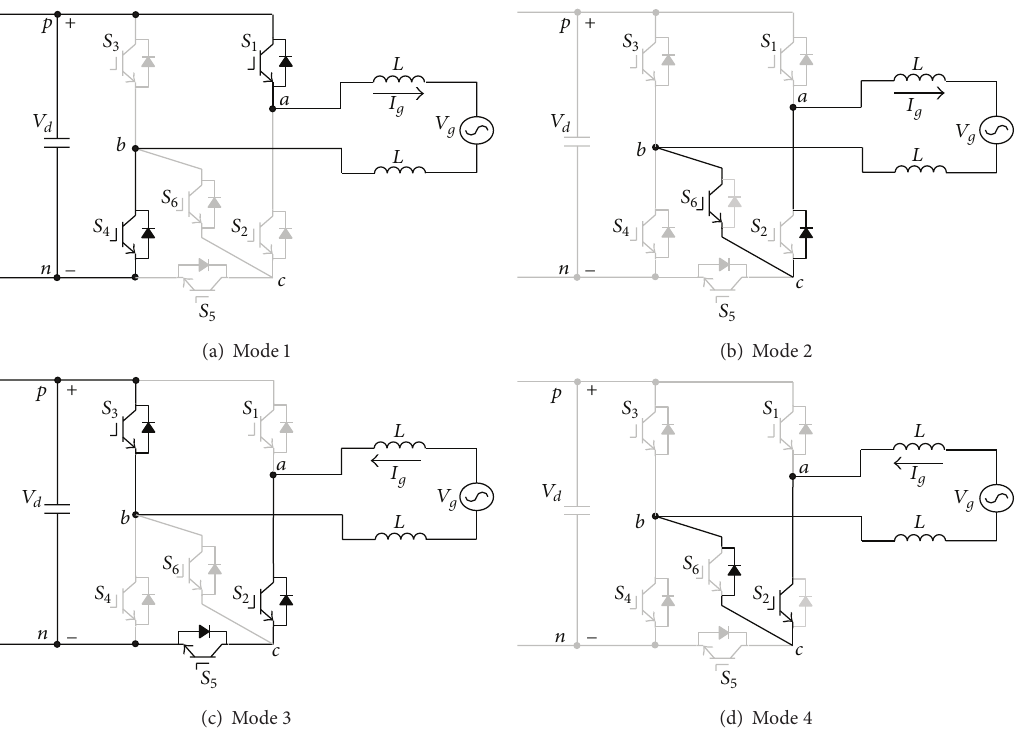
Figure 4: Operation modes of the proposed